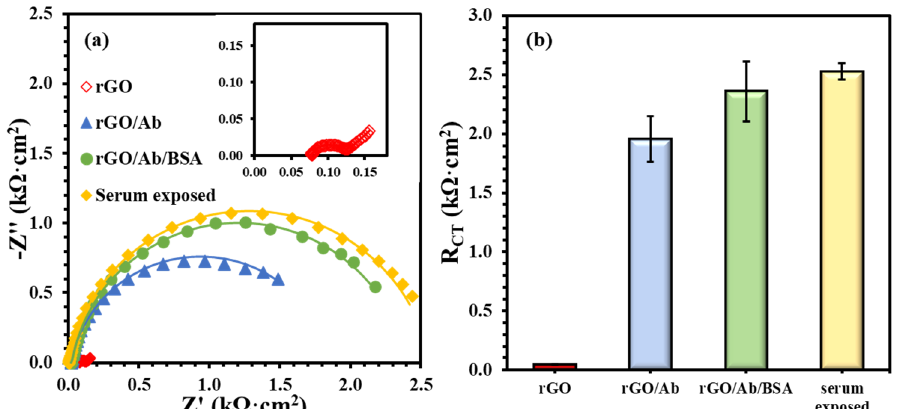
Figure 1. ( a ) EIS plots for biolayer formation including unmodified rGO surface (inset), anti-Nf-L antibody rGO/Ab, after 1% BSA treatment rGO/Ab/BSA, and after the human serum exposure. ( b ) Comparing R CT values after modifying the rGO electrode with each successive layer. The error bars represent n ≥ 4 distinct replicates.